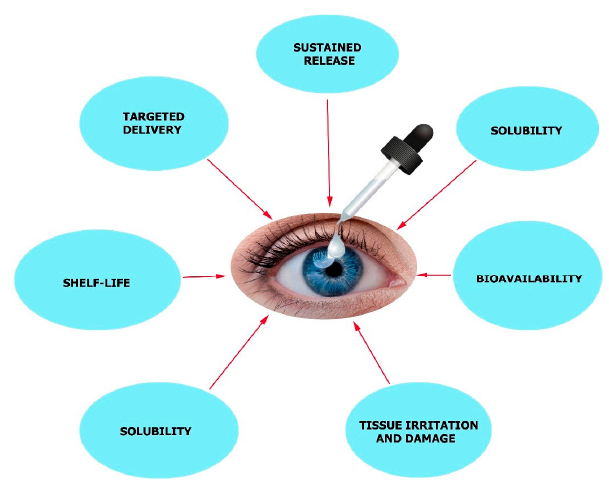
Figure 3. Major challenges in ocular disease treatment with eye drop formulations.